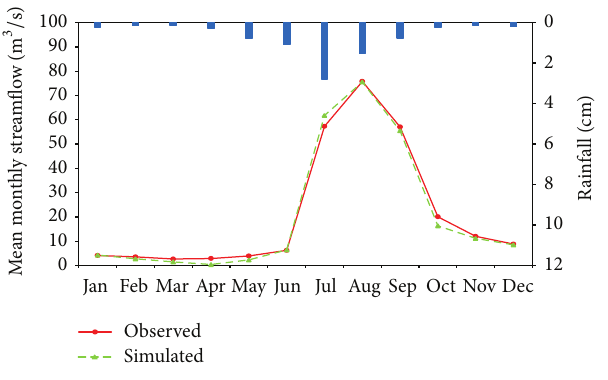
Figure 4: Comparison of observed and simulated results for monthly mean rainfall-runoff simulation in Jiaoyi watershed during calibration period (2001 ∼ 2004).